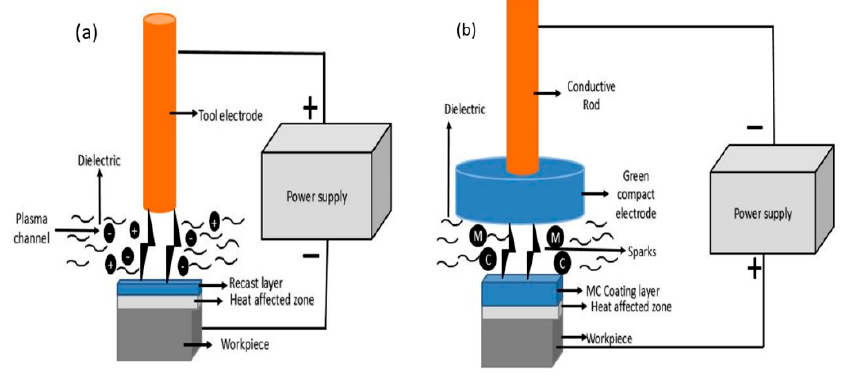
Figure 4. ( a ) EDM mechanism and ( b ) EDC mechanism.